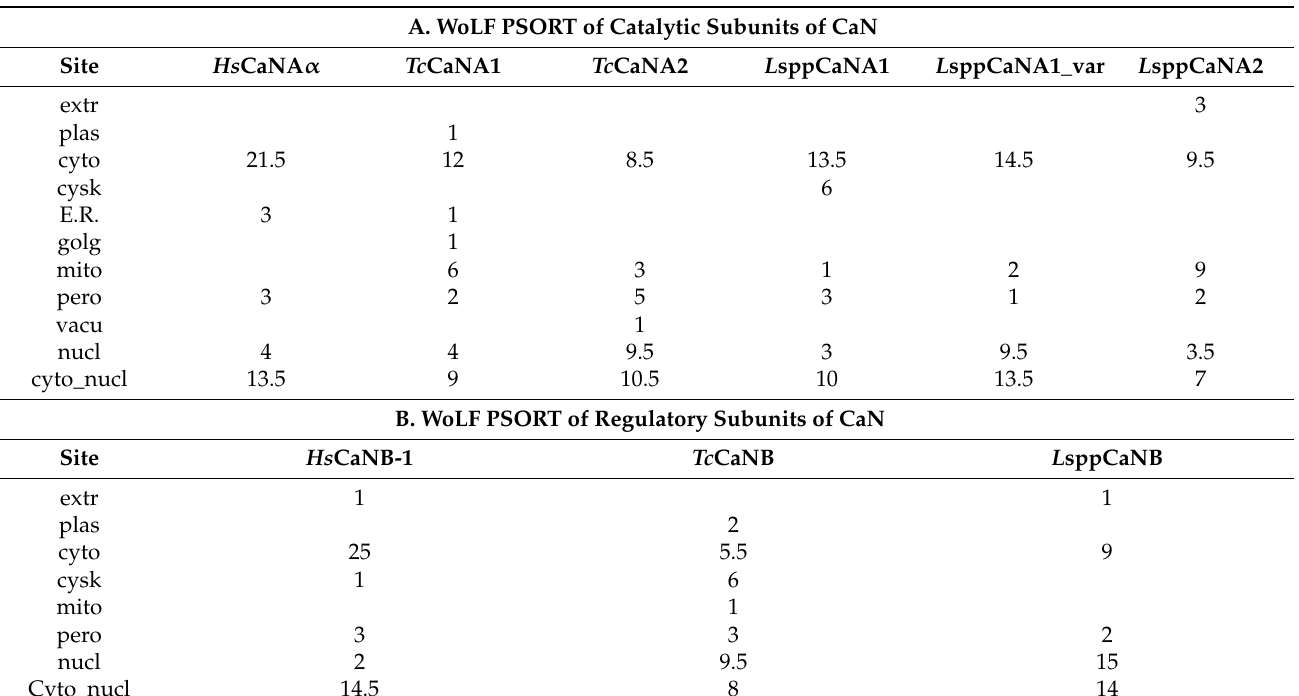
Table 3. Predicted subcellular localization of CaNs based on WoLF